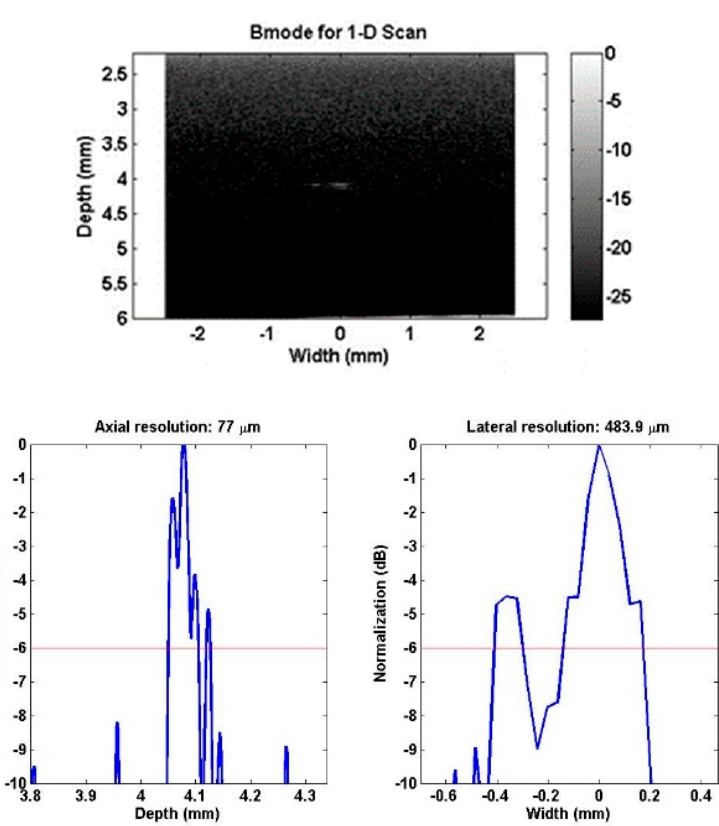
Figure 8. Wire target image and − 6 dB resolutions of BNT-BT transducer.